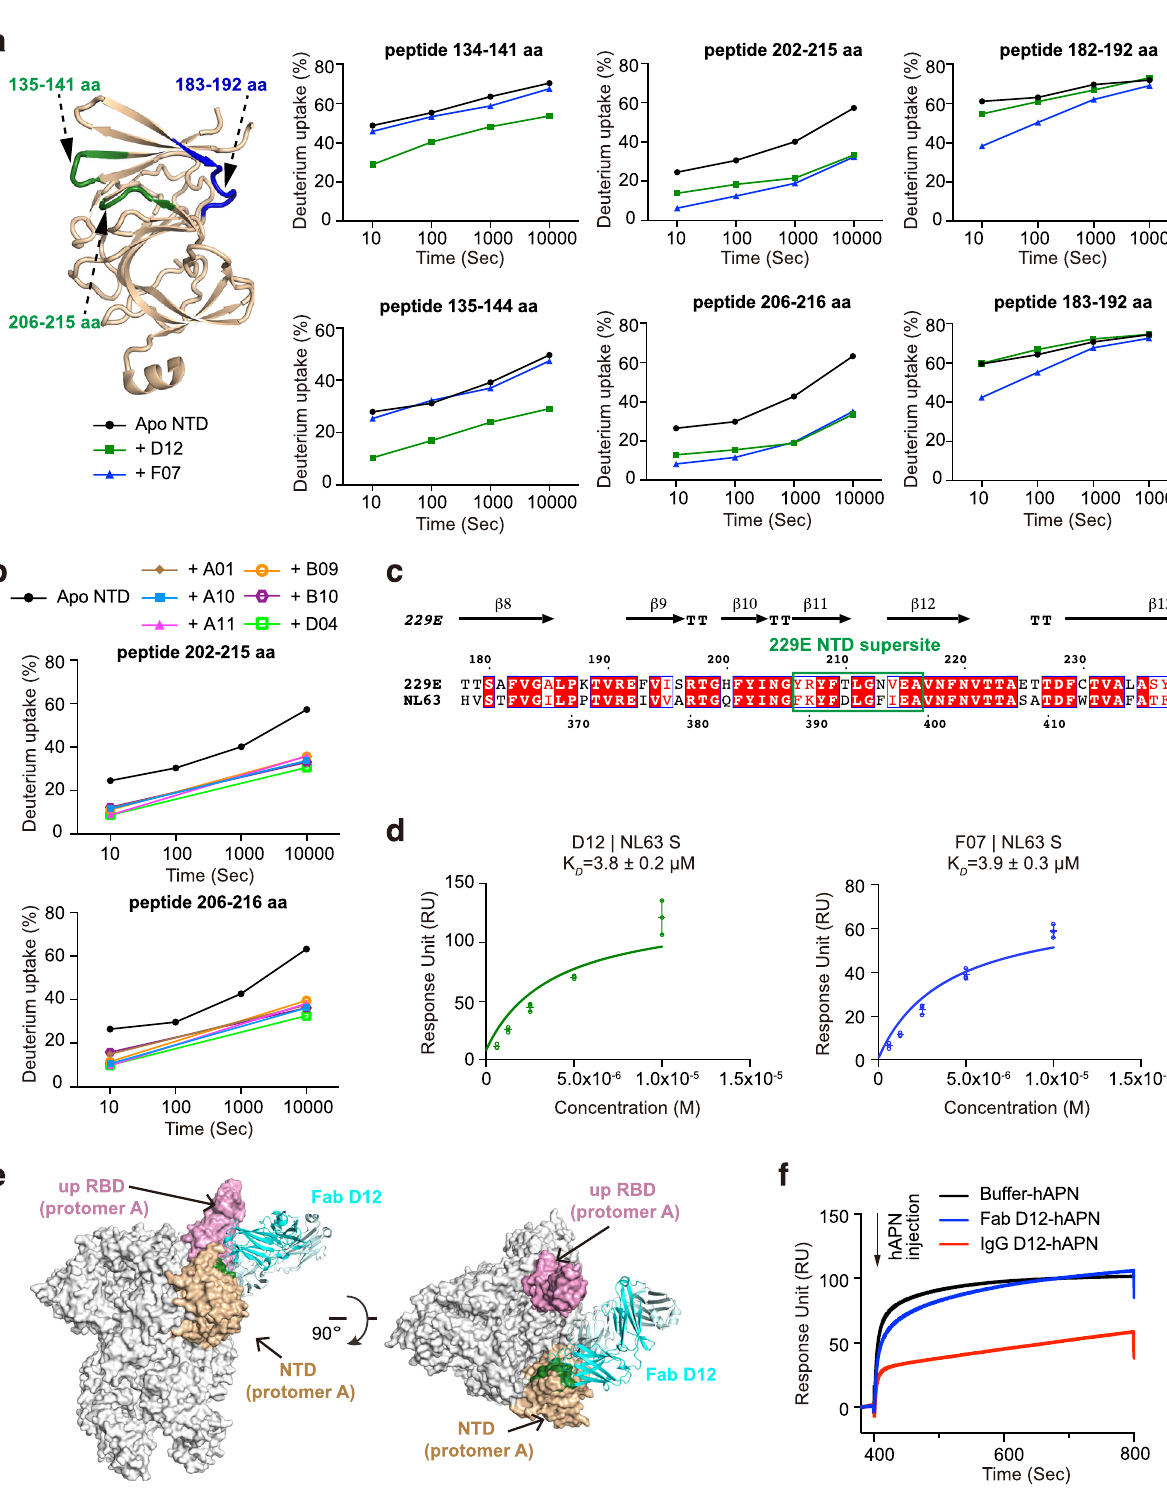
(Fig. 3c, compare the right two panels). Moreover, the reference- to the 2D projections of the docking model (Fig. 3c, compare the left two panels), further corroborating the docking model.